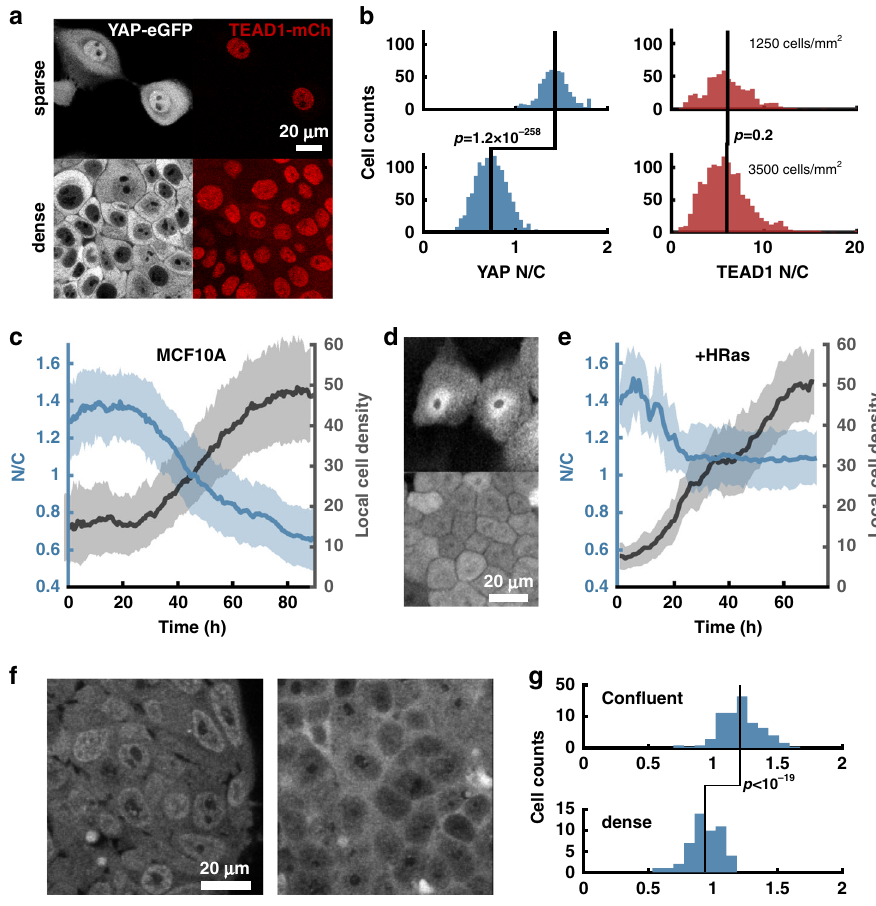
Fig. 2 YAP and TEAD localization dynamics: Density sensing. a Dense and sparse MCF10A cells with YAP-eGFP and TEAD1-mCherry dual CRISPR knockin. b N / C of YAP and TEAD1 in MCF10A at various densities. N = 584 for sparse condition (1250 cells/mm 2 ), and N = 1272 for 3500 cells/mm 2 . A one-sided Mann – Whitney U -test was used to test differences in N / C ratio between conditions. For YAP sparse vs. dense: P = 1.2e − 258, Z val: 34.3, Ranksum = 910,364. For TEAD sparse vs. dense: P = 0.23, Z val = 1.1930, ranksum = 555,036. Repeated three times with similar results. c Time-lapse of YAP-eGFP nuclear/cytoplasmic ratio ( N / C ) during monolayer growth for MCF10A (solid line is mean value, and shading is standard deviation) ( N = 915 cell tracks). Data from one representative experiment. Repeated three times with similar results d Native YAP-eGFP expression/localization in sparse and dense cultures of MCF10A-HRas (MCF10AT), highlighting lack of YAP nuclear exclusion at high density. e Time-lapse of YAP-eGFP nuclear/cytoplasmic ratio ( N / C ) during monolayer growth for MCF10AT ( N = 1478 cell tracks, solid line is mean value, and shading is standard deviation). Data from one representative experiment. Repeated three times with similar results. Neighbors in c and e is the average local cell density, de fi ned as the number of cell centroids located with a 250-pixel radius. f Representative images of H1 hESC YAP -GFP-KI cells at con fl uent and very high density. g Quanti fi cation of YAP N / C in experiments from f . A one-sided Mann – Whitney U -test was used to test differences in YAP N / C . N = 161, N = 50 cells. P = 2.66 × 10 − 7 , con fl uent dense Ranksum = 18,761. Repeated twice with similar